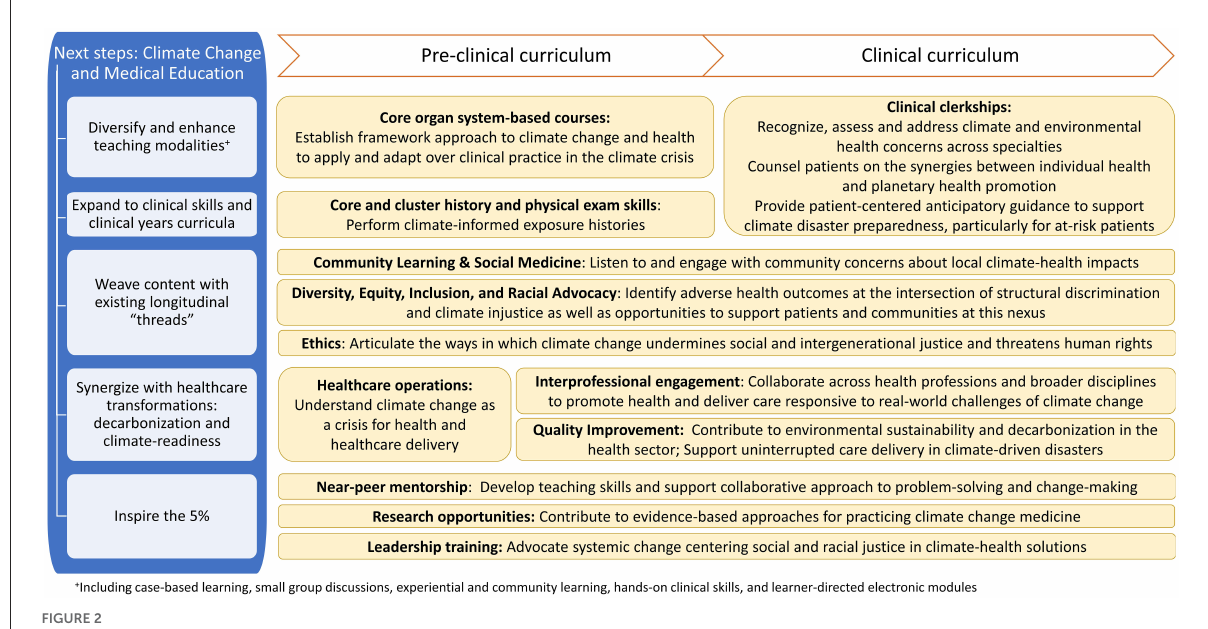
FIGURE2 Climate change and environmental health in medical education: Curricular opportunities and learner outcomes informed by student perspectives. + including case-based learning, small group discussions, experiential and community learning, hands-on clinical skills, and learner-directed electronic